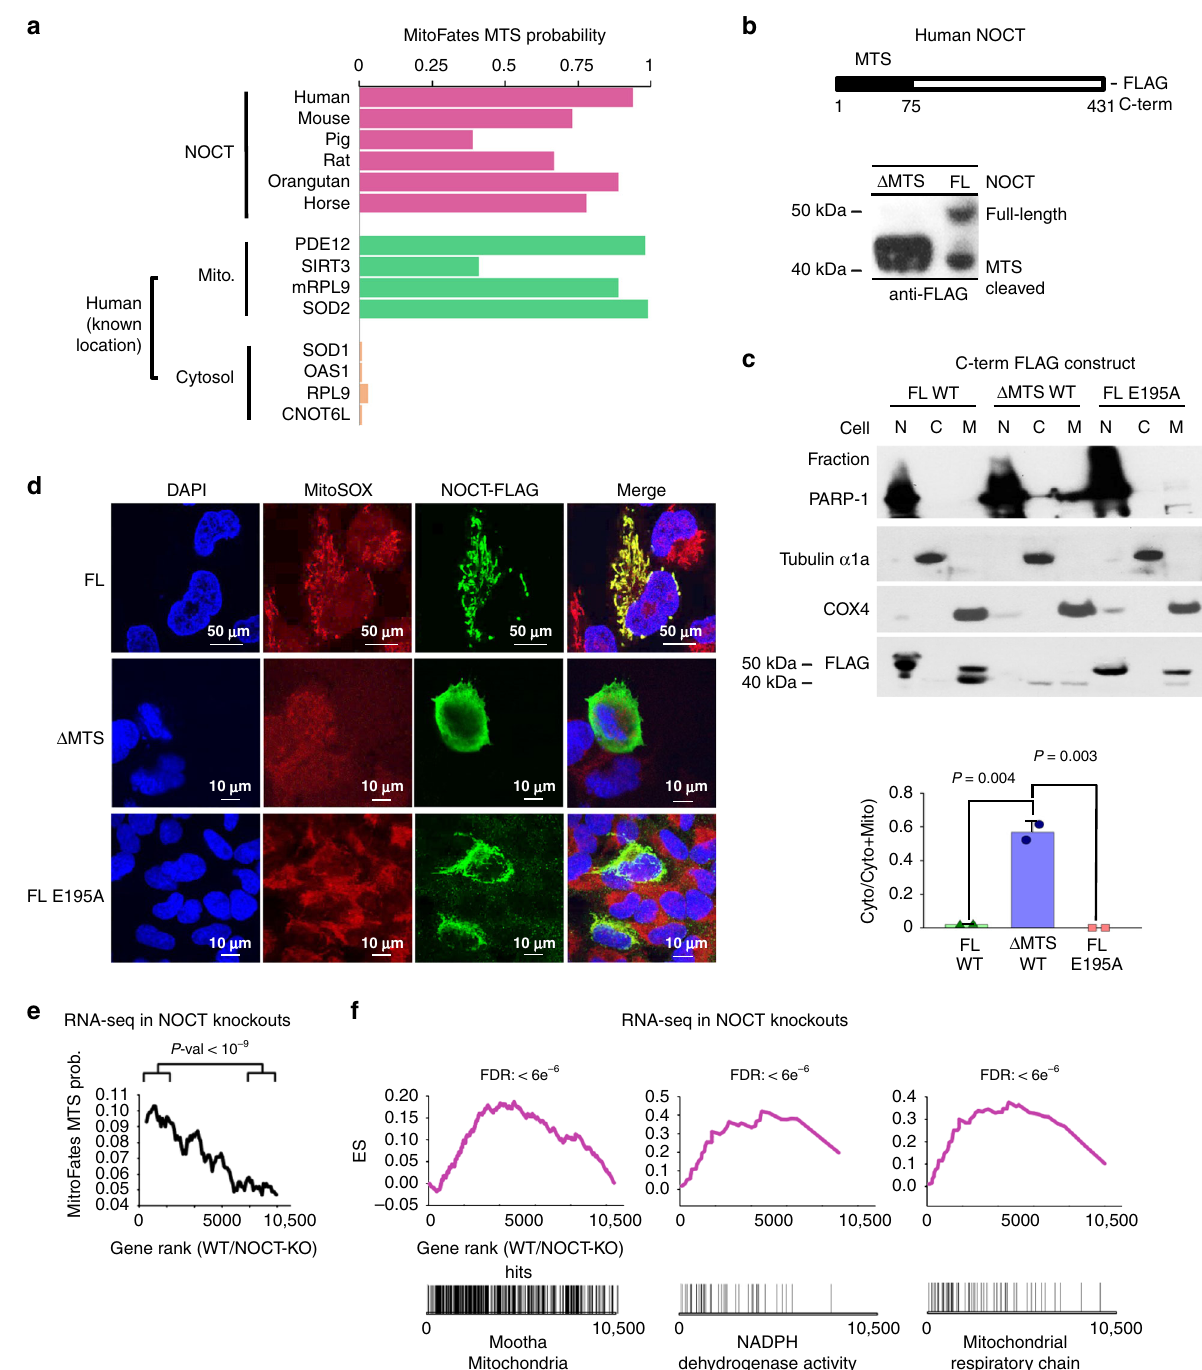
Fig. 3 Evidence for NOCT mitochondrial localization. a MitoFates analysis of NOCT and reference human proteins. b Western blot for FLAG-NOCT, full- length vs Δ MTS. c Subcellular fractionation and western blot analysis of FLAG-NOCT, WT, Δ MTS, and E195A active site mutant. Error bars show S.E. from the data in c and Supplementary Fig. 3a, P -values here and throughout were determined by Welch ’ s two-tailed unpaired t -test. PARP-1, Tubulin, and COX4 mark the nucleus, the cytosol, and the mitochondria, respectively. d Confocal microscopy of NOCT variants in c . DAPI stains for nuclei, MitoSOX stains mitochondria. e Running average for MitoFates scores for ~10,500 mRNAs ordered according to gene expression levels in WT vs NOCT − / − cells, measured by RNA-seq (data are provided in Supplementary Data 3). P -values for top 2000 vs bottom 2000 mRNAs. Error bars represent S.E. RNA-seq data represent four RNA-seq experiments: two in WT cells and two in independently derived NOCT-KO clones. f GSEA enrichment results for the genes with ≥ 50 reads, ranked according to WT/NOCT − / − expression as in e (Supplementary Data 3). Source data are provided as a Source Data fi